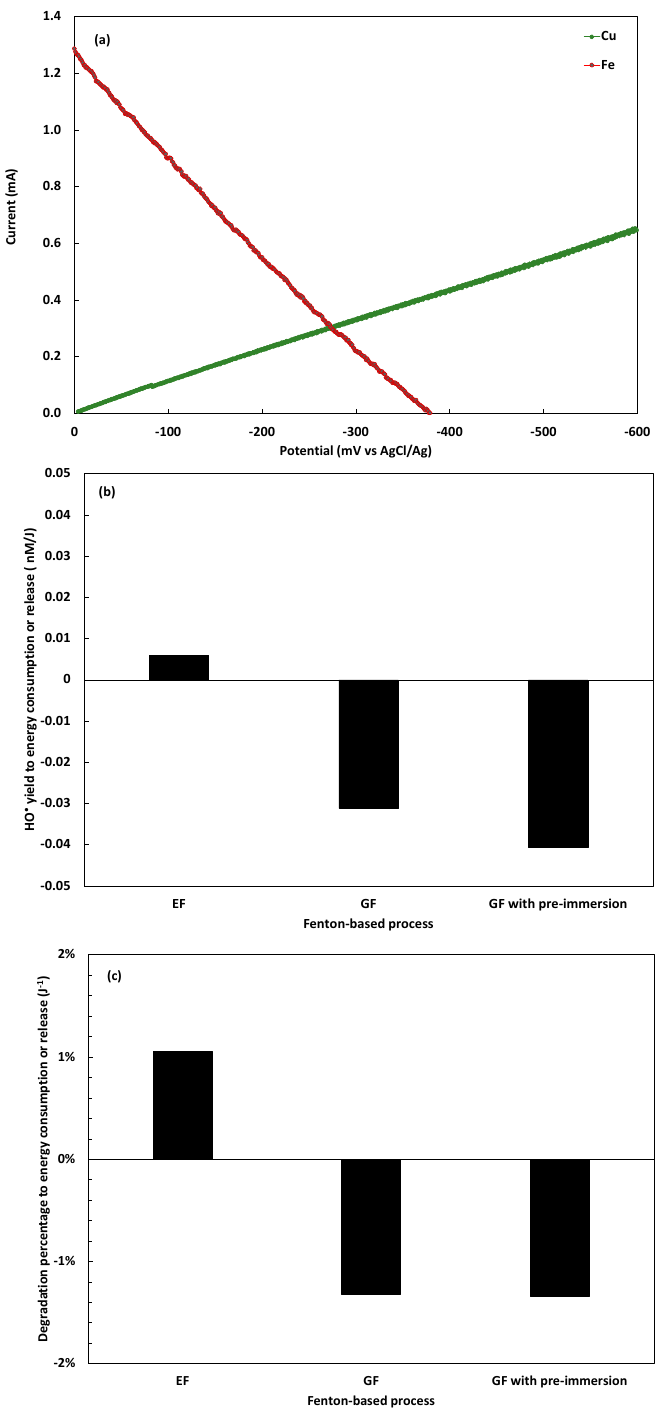
Figure 9. Polarization curves of the Fe-Cu galvanic cell within the Galvano-Fenton process in the presence of H 2 O 2 ( a ) and ratios of the HO • yield ( b ) and phenol degradation percentage ( c ) to the consumed or released energy.